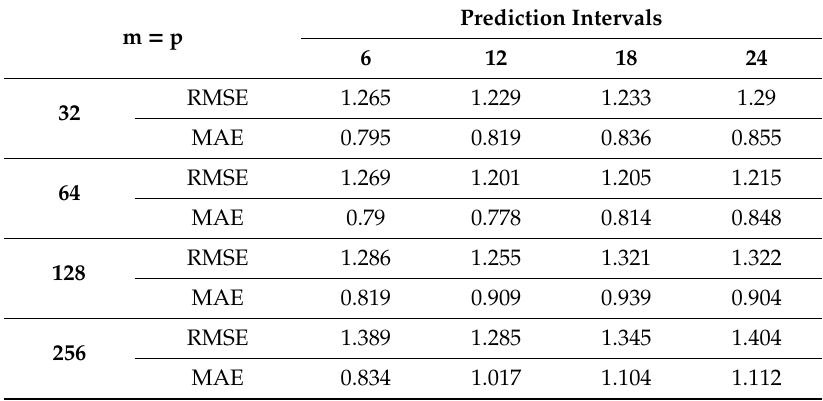
Table 3. Parameter